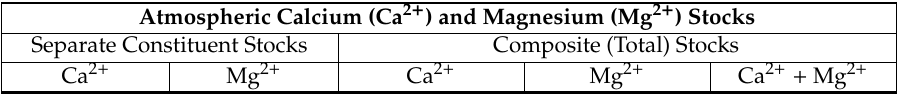
Table 2. Types of atmospheric calcium and magnesium stocks.